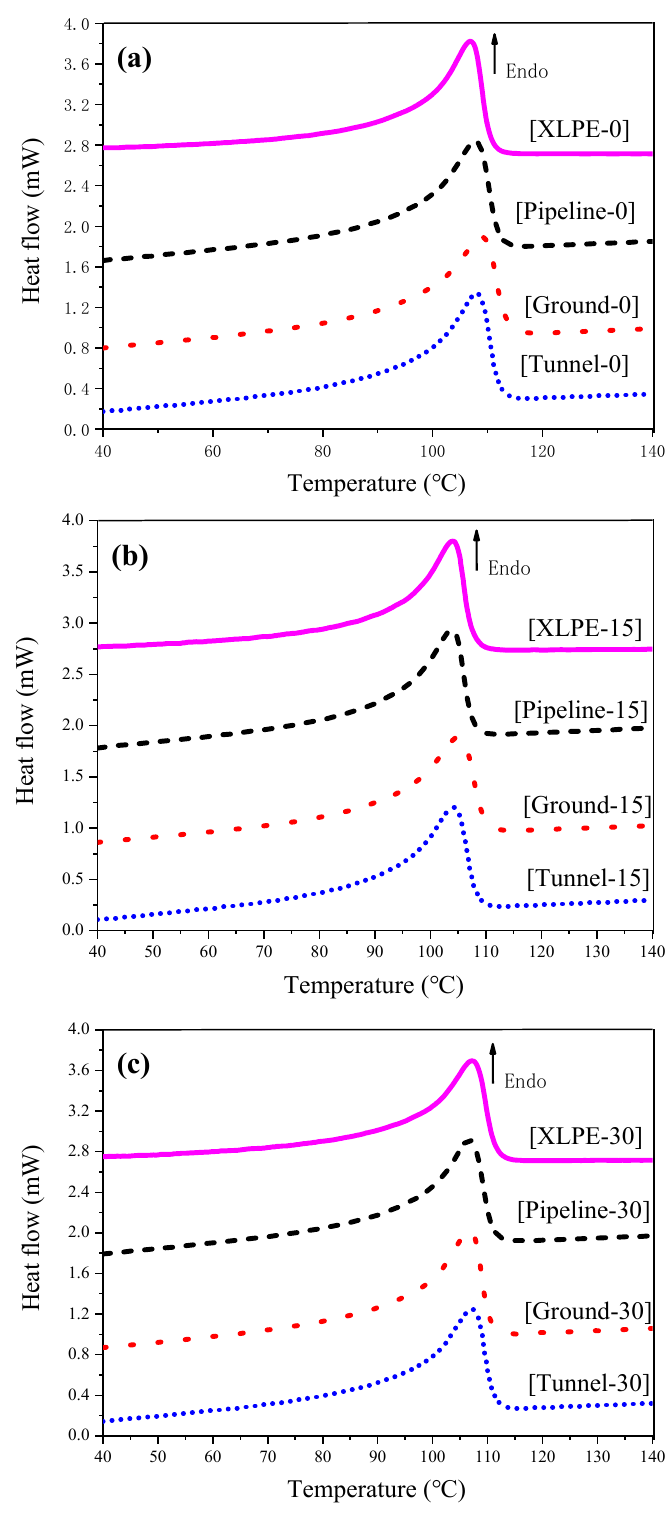
Figure 8. Heat flow as a function of measurement temperature in the second heating of differential scanning calorimetry (DSC). ( a ) the spare cable; ( b ) the cable with service years of 15; ( c ) the cable with service years of 30.